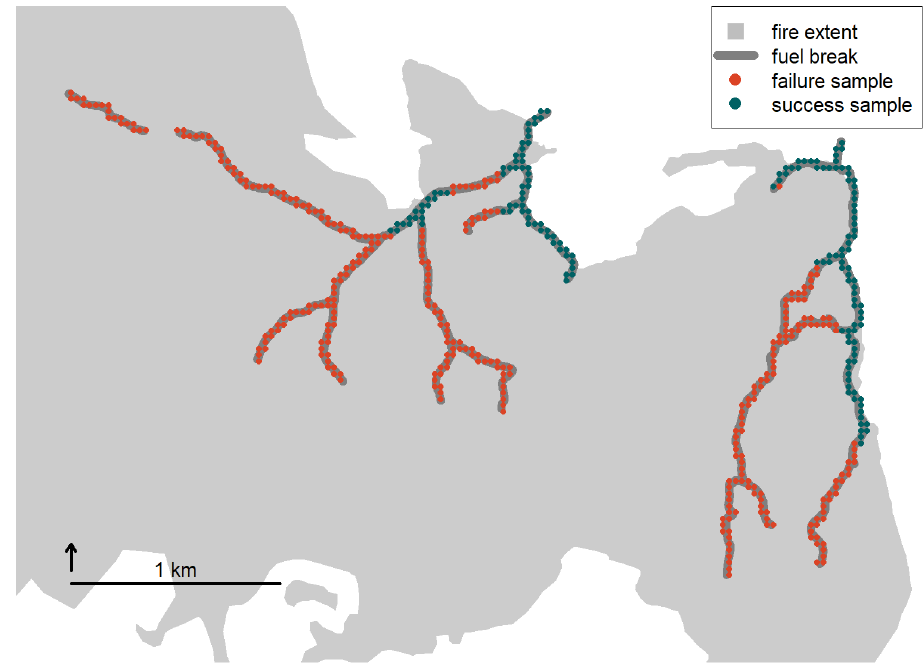
Figure 2. Example of fuel break samples and outcomes for the 2019 Saddle Ridge Fire. Samples were generated by rasterizing the fuel break polylines and converting the cell centers into points. Samples were considered successfully held if they fell within 100 m plus half the fuel break width of the final fire perimeter.